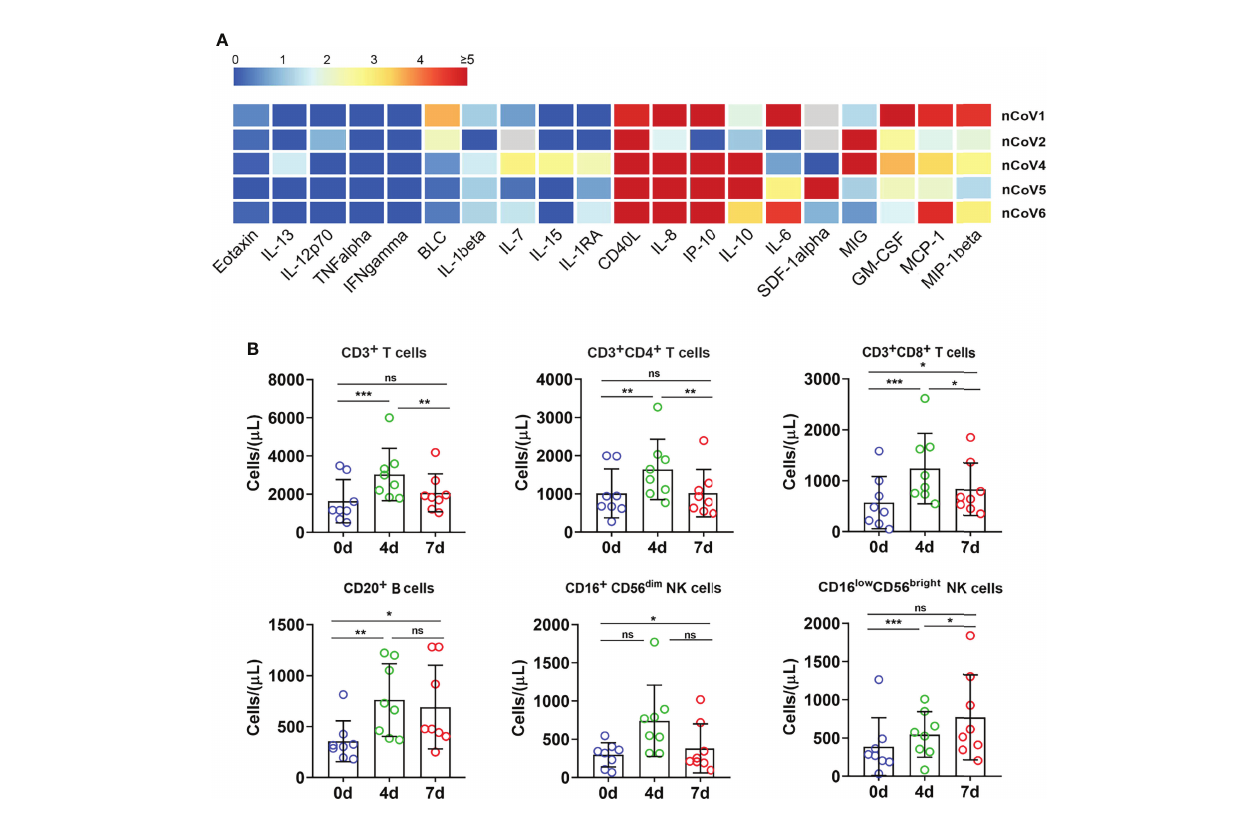
FIGURE 4 | In fl ammatory cytokines and immune cell subpopulations in COVID-19 macaques. (A) In fl ammatory cytokines in serum samples from macaques before and after challenge were measured by Luminex multiplex assays as described in the “ Materials and methods ” section. The scale bar indicates the change-fold of the cytokines at 7dpi, compared with themselves at before exposure. (B) The proportion of immune cells including CD3 + , CD4 + , and CD8 + T lymphocytes, CD20 + B lymphocytes, and NK cells were analyzed by fl ow cytometry. *p<0.05; **p<0.01; ***p<0.005. ns, not signi fi